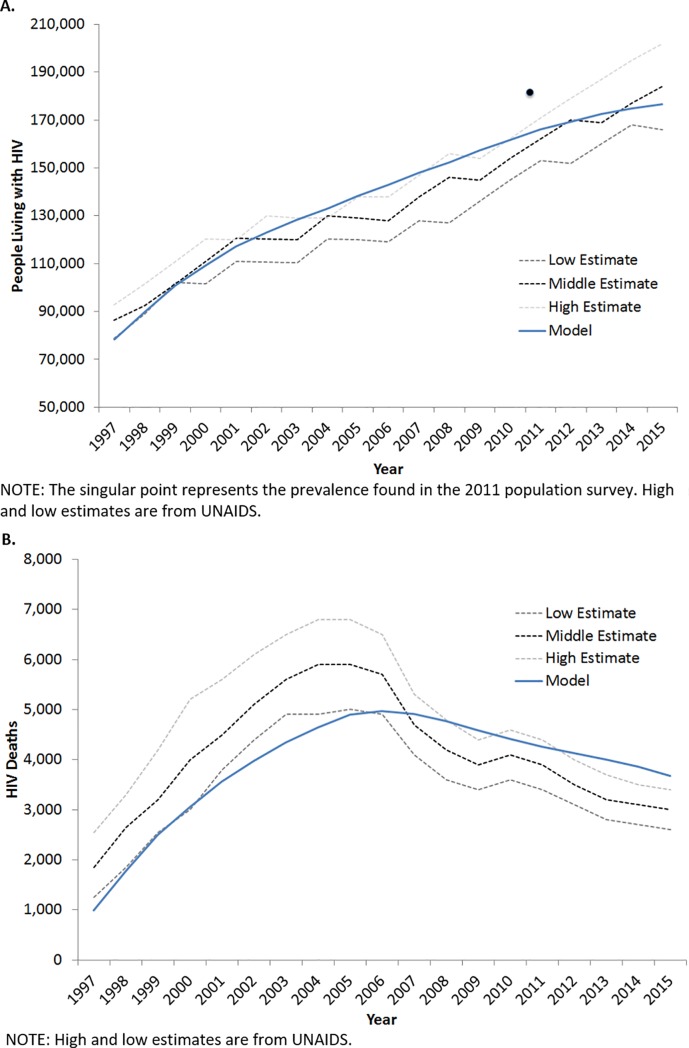
Calibration (A) Number of persons living with HIV, (B) Number of HIV Deaths. A. NOTE: The singular point represents the prevalence found in the 2011 population survey. High and low estimates are from UNAIDS. B.NOTE: High and low estimates are from UNAIDS.